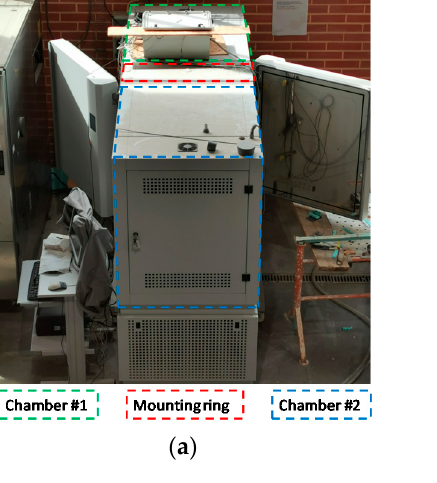
Figure 9. Hot box heat flux meter approach: ( a ) hot box apparatus ( b ) schematic layout of heat flux meter and temperature sensors positioning on the specimens’ surfaces.